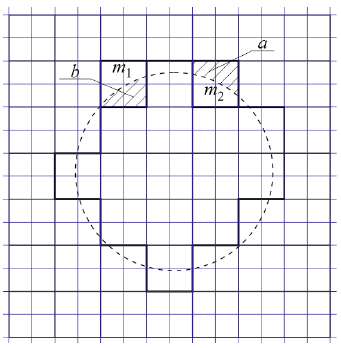
Fig. 2. A model for discretization of the round mark image. A pixel located on the periphery of a true continuous mark image is included in the registered discrete mark image, if most part of its area belongs to a continuous mark image, and is not included, otherwise. And the smaller part of the pixel, which in the first case is not included in the mark image, but is included in the second case, is the elementary error of discretization of the mark image. In Fig. 2, the elementary errors of the discretization of the mark image introduced by a and b pixels are shaded. The elementary discretization error of the mark image has a plus sign, if it is included in the registered discrete mark image, and a minus sign, otherwise. The elementary discretization error of the mark image ε pix is a random variable, evenly distributed in the range from minus 0.5 run 2 to 0.5 run 2